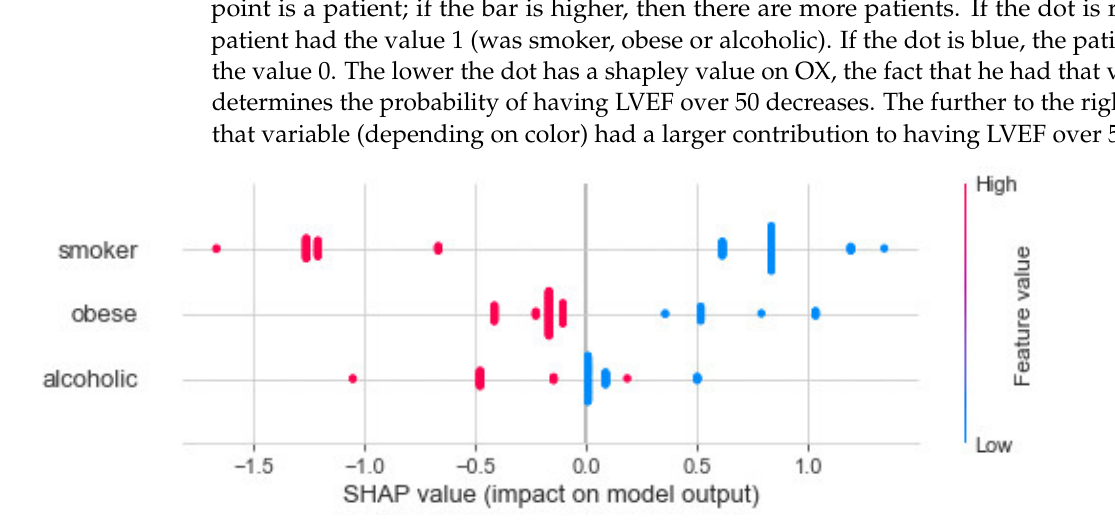
Figure 4. Shapley values for behavioral variables.